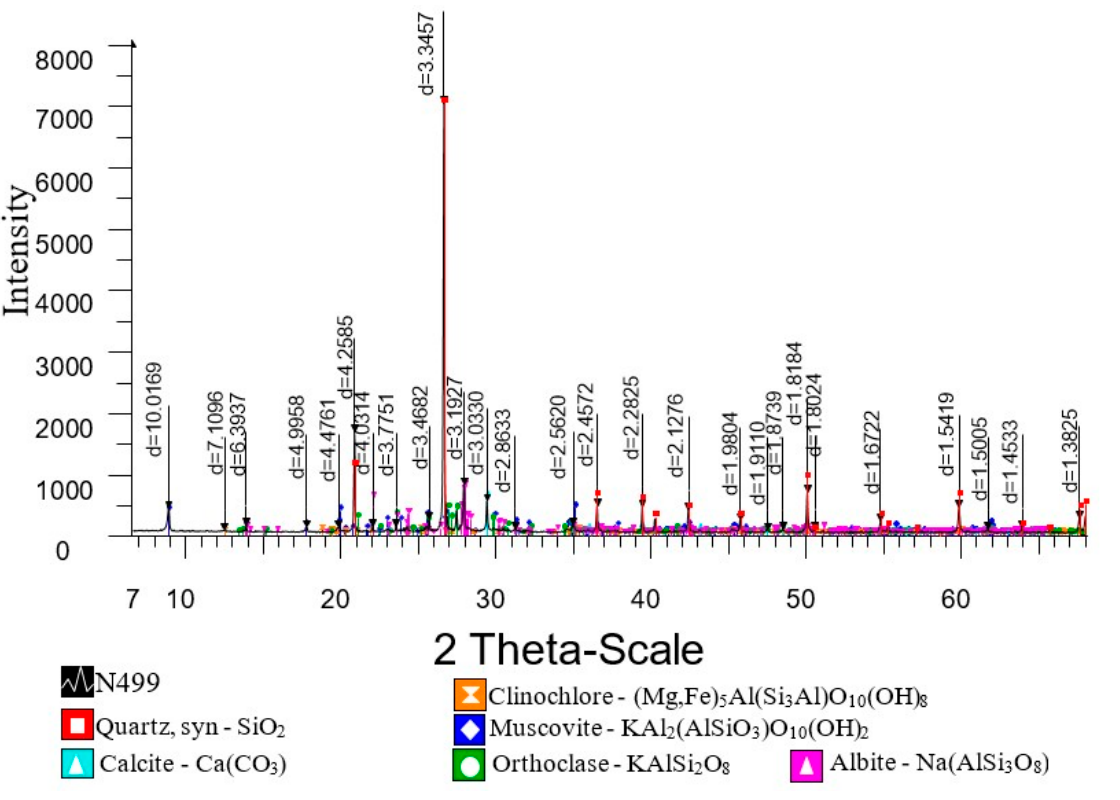
Figure 3. Diffractogram of the flux ore Taskara.